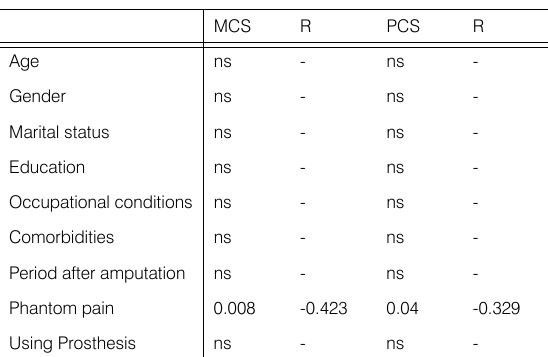
Table 4. Correlations between the PCS (Physical Component Scale) score, the MCS (Mental Component Scale) score and sociodemographic data (p-value, R-Spearman coefficient, if statistically significant) in patients after limb